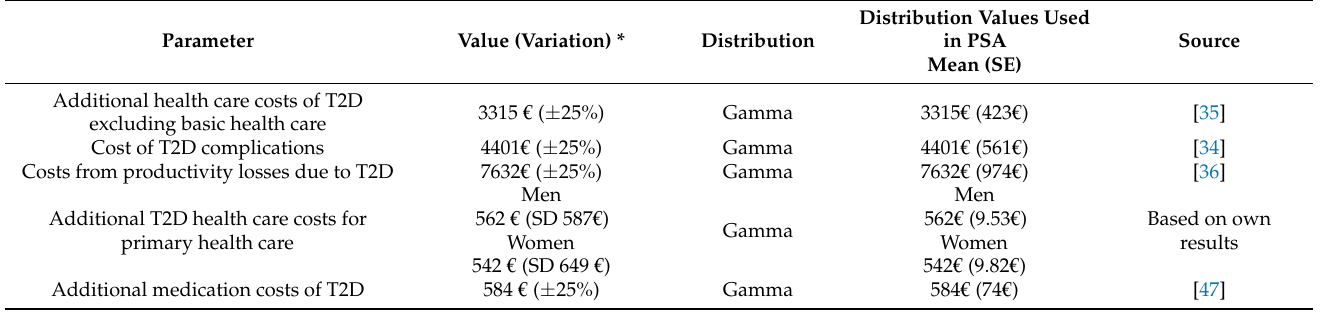
Table 2. Costs applied in the Markov model, their distributions, and the values used to estimate the distributions. Costs before 2019 have been discounted to the latest values.